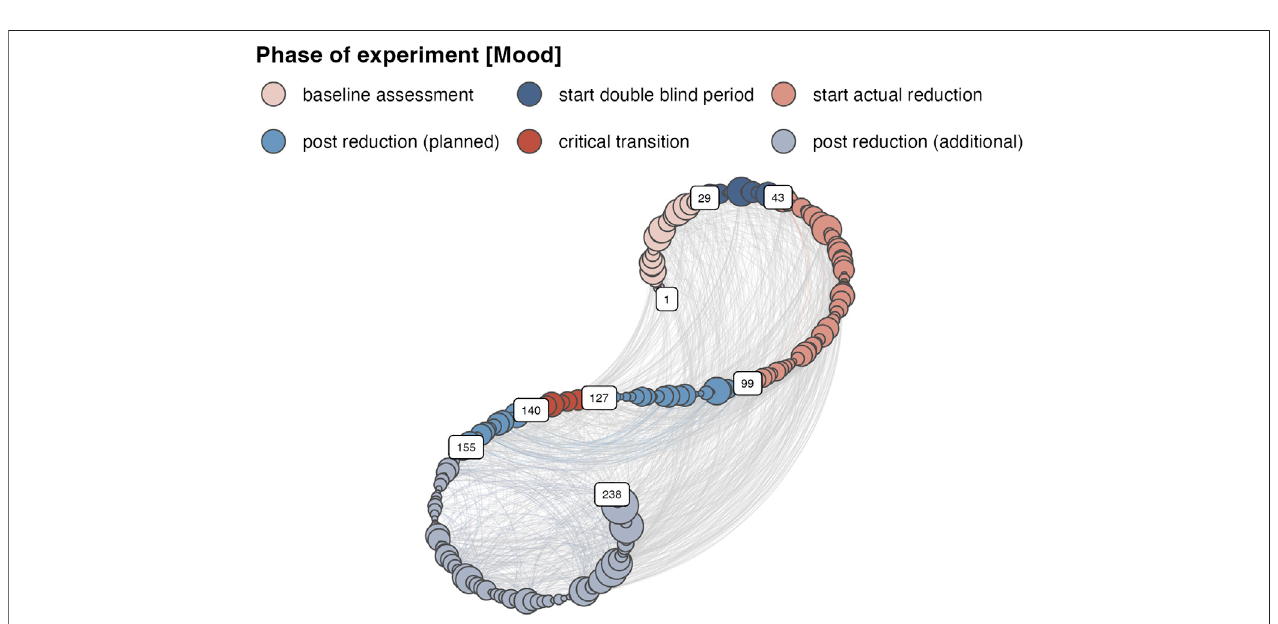
FIGURE 3 | A Recurrence Network in spiral layout based on the distance matrix of 12 time series representing self-reports of the mood of an individual recorded over a period of 238 days.